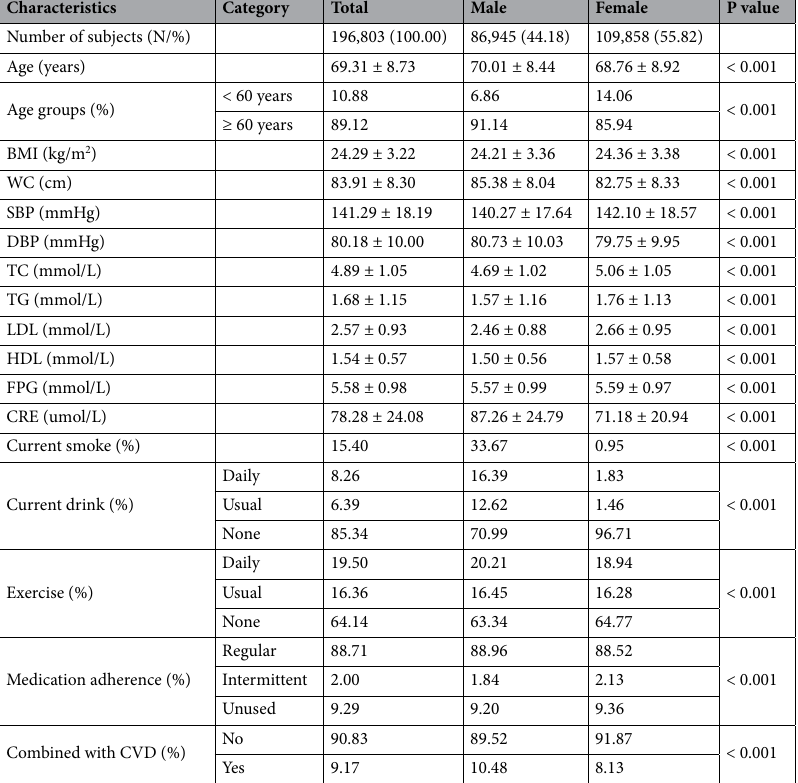
Table 1. General characteristics of